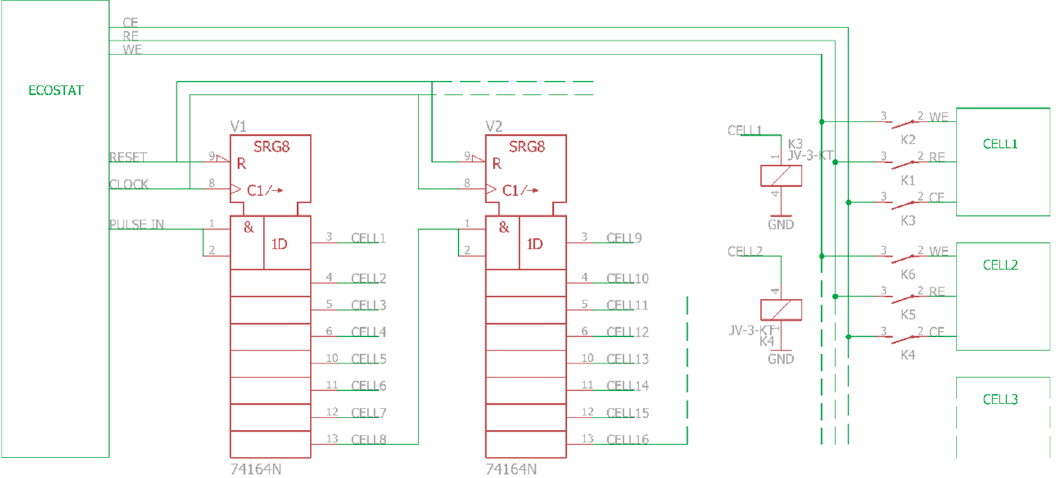
Figure 3. Schematic of the multiplexing unit as an extension of the EcoStat device.